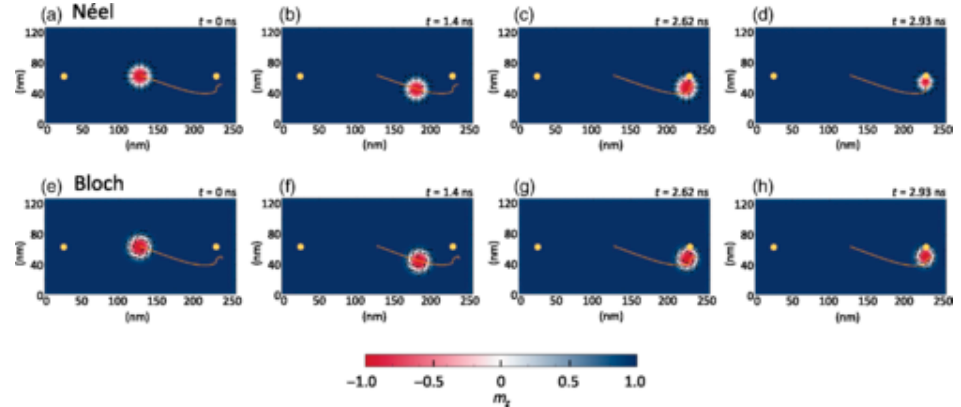
Figure 5. Time-dependent position of ( a – d ) Néel, ( e – h ) Bloch Skyrmion due to a fixed voltage without local pinning. Reprinted with permission from [47]. Copyright (2018) by the American Physical Society.